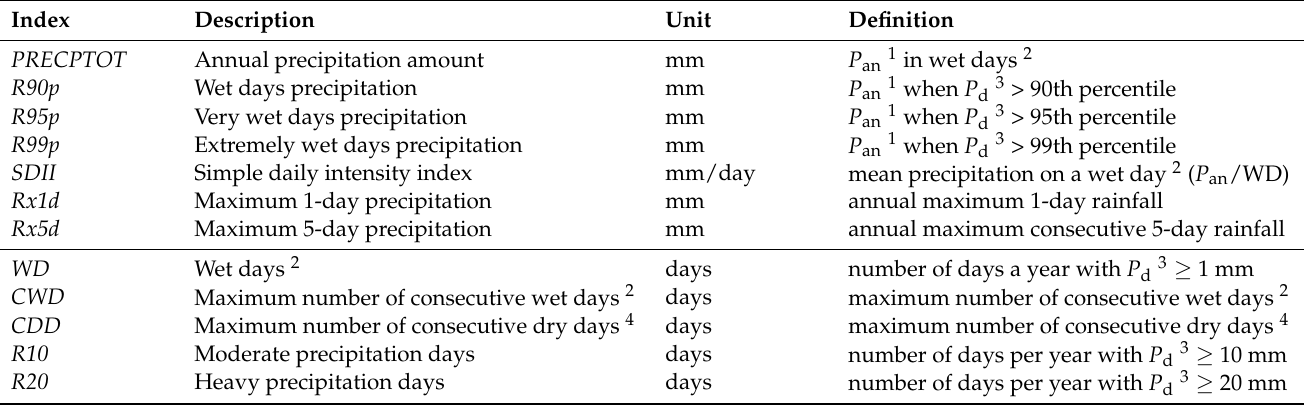
Table 2. Characteristic indices of the rainfall regime, recommended by